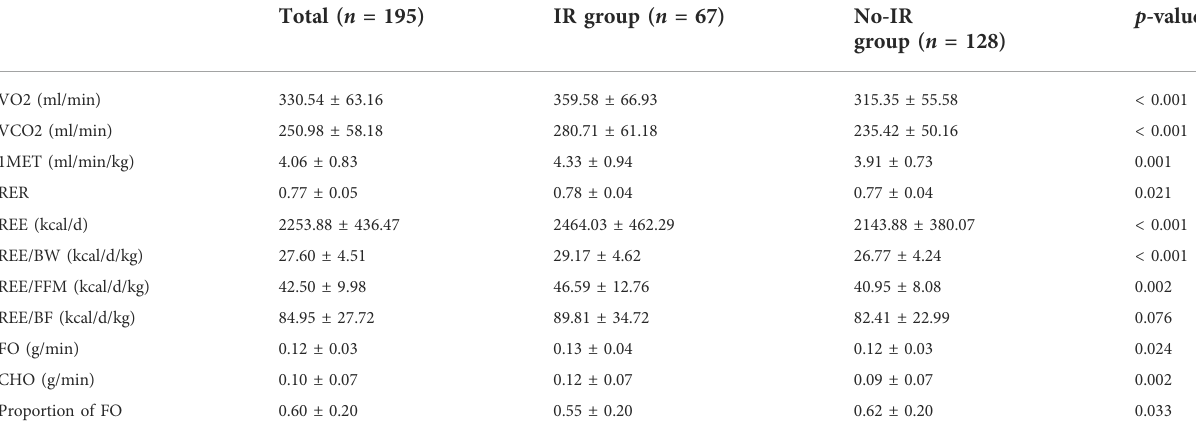
TABLE 2 Characteristics of resting metabolic in IR and no-IR